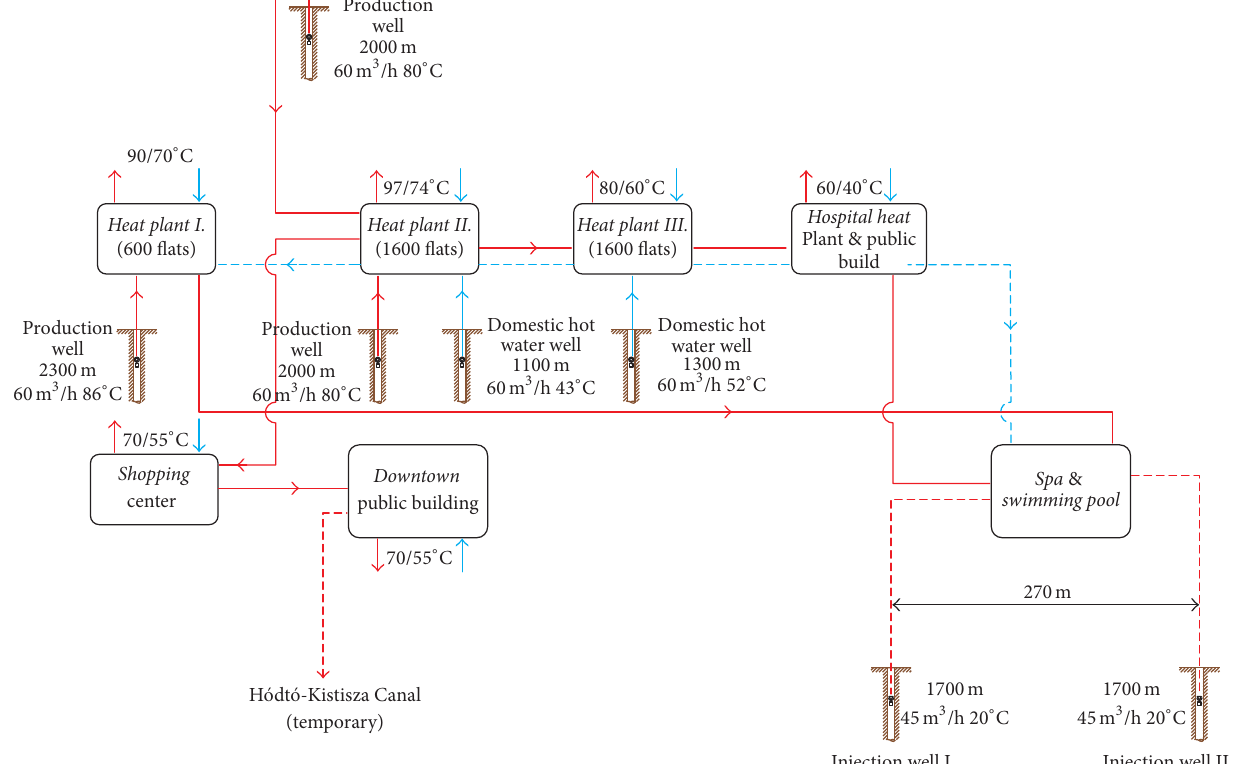
Figure 2: The schematic drawing of the cascade system in H´odmez˝ov´as´arhely (modified from [8]).